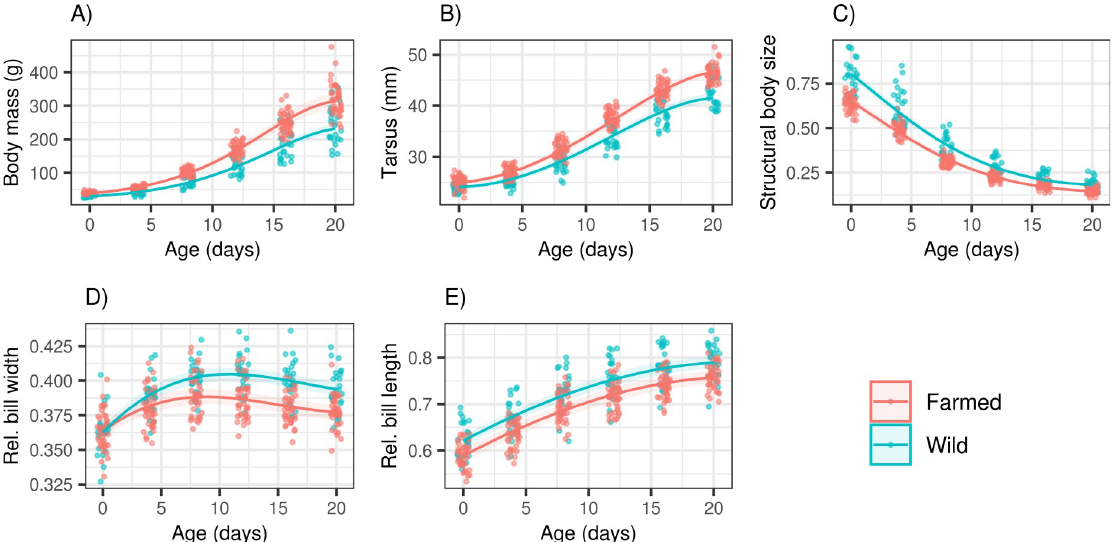
Fig 2. Growth curves for five morphometric parameters. (A) body mass, (B) relative body size, (C) structural body size (i.e. relative tarsus length), (D) relative bill width, (E) relative bill length in farmed and wild mallard populations (n wild = 24, n farmed = 40). Predictions are based on polynomial mixed effect models. The shaded area corresponds to 95% confidence